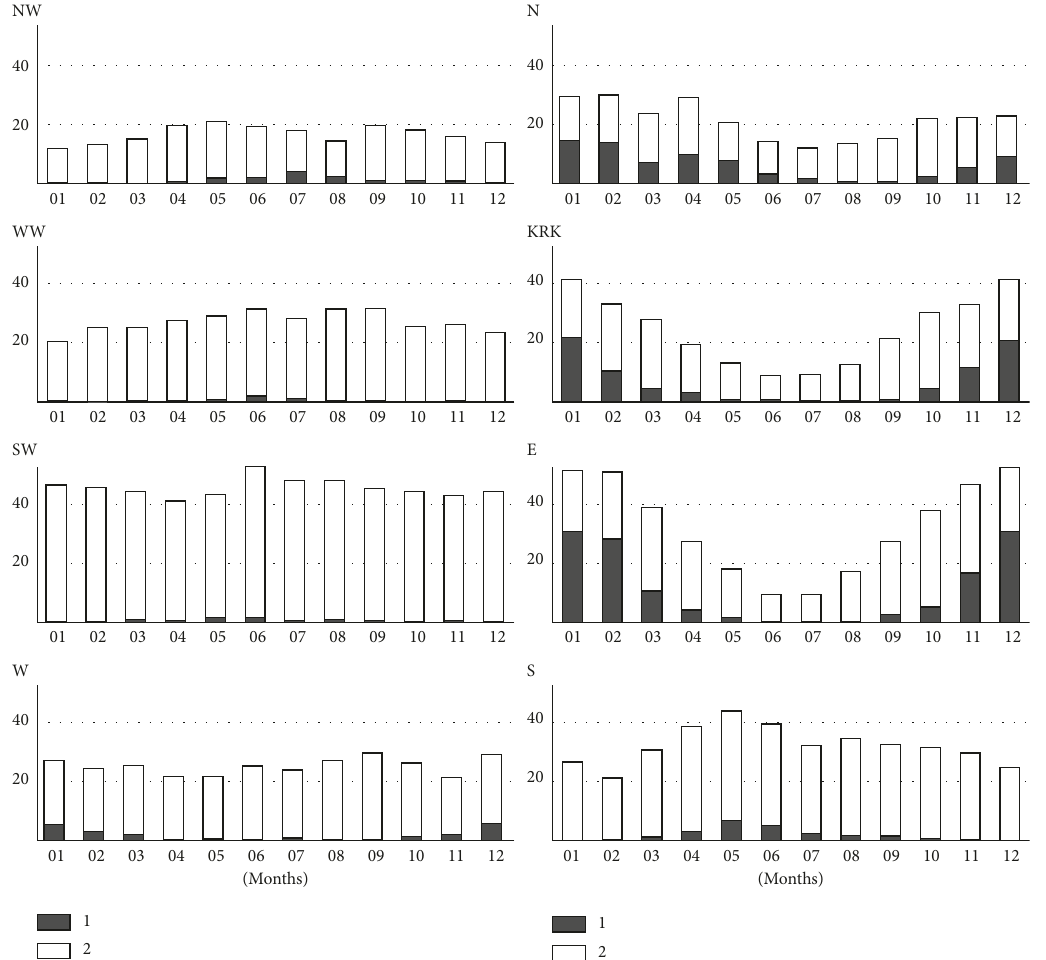
Figure 5: Frequency (%) of humidity inversion occurrence: (1) surface-based and (2) elevated at selected grid points (for details, see Figure 1 and Table 1)